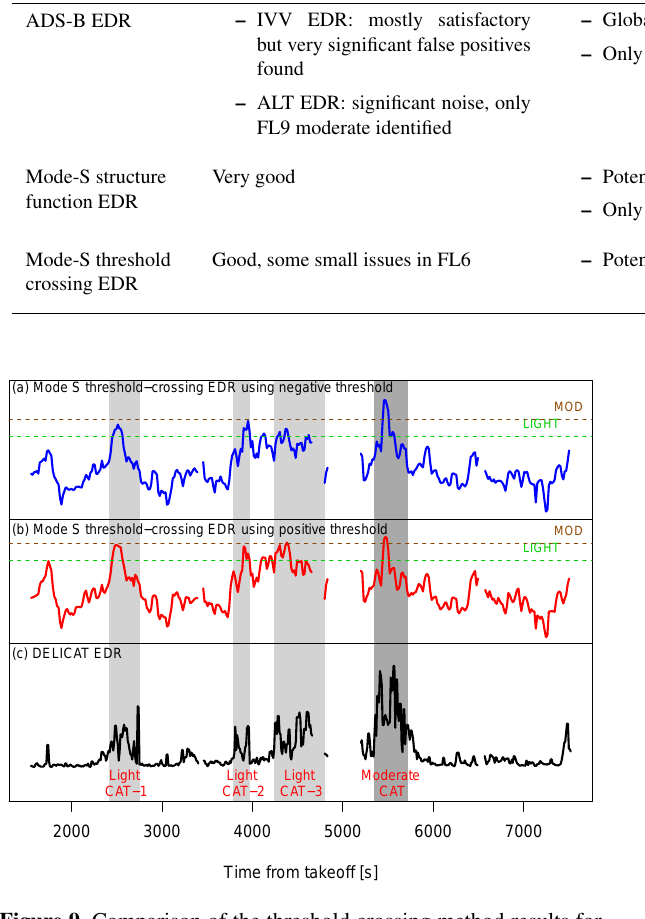
Table 3. Summary of the EDR estimation approaches. Method